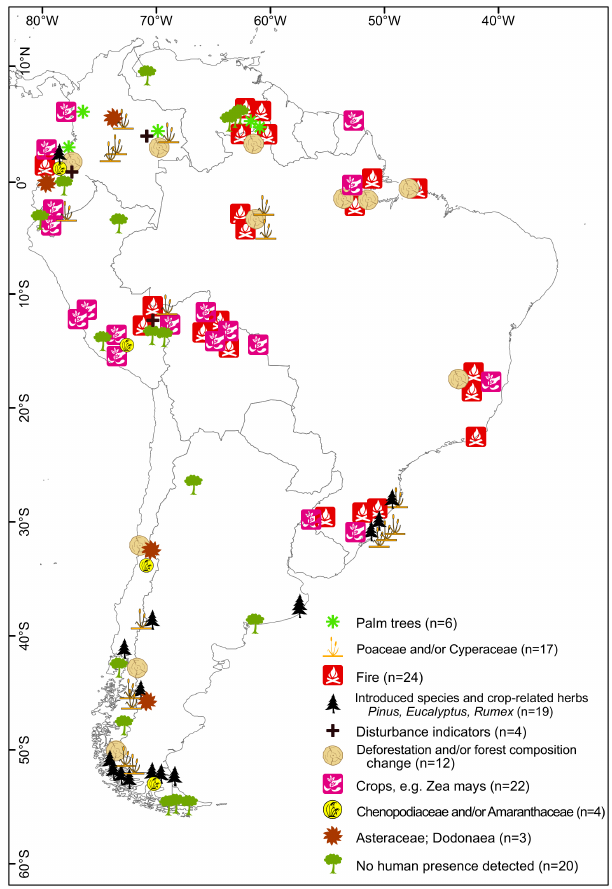
Figure 14. Map showing human indicators observed in the pollen records discussed ( n = 68). The number of pollen records for each human indicator is shown in the figure legend. A pollen record can have different human indicators, and therefore the symbols may show an offset relative to their exact location to avoid overlapping point symbols. Details are found in Table